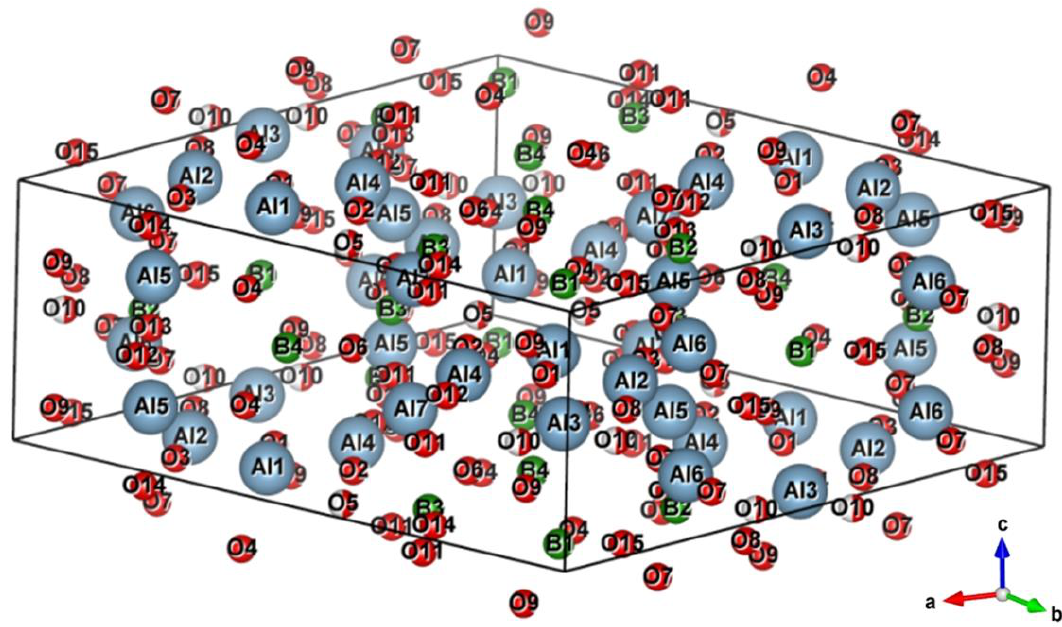
Figure 5. 3D image of the Al 4 B 2 O 9 lattice after refinement of structural parameters by the Rietveld method.